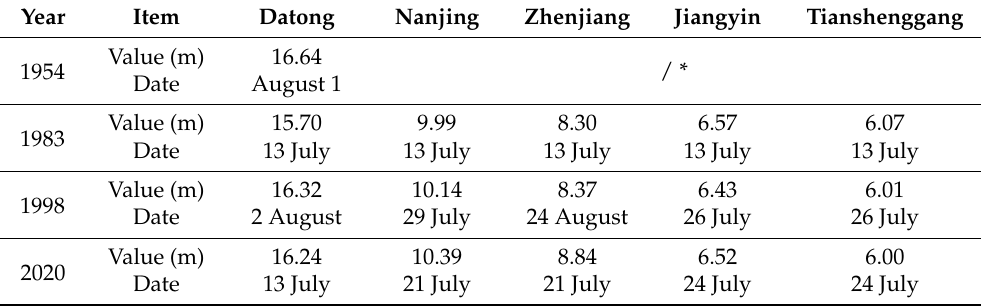
Table 2. Highest water (tide) level at different stations (gauges) and the date of occurrence in typical flood years since the